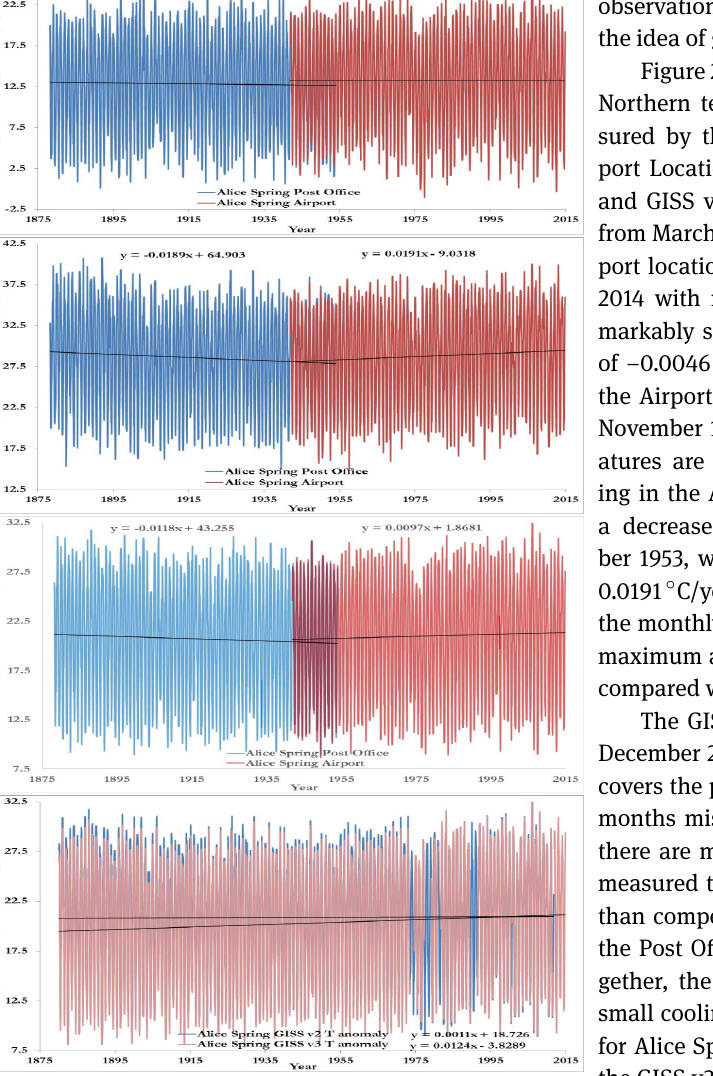
Fig. 2: Comparison of the truly measured temperatures for the Al- ice Springs, Northern Territory of Australia location with the GISS v2 and v3 representations. The actual measurements by the ther- mometers show a small cooling misrepresented as a small warming by GISS v2 and a large warming by GISS